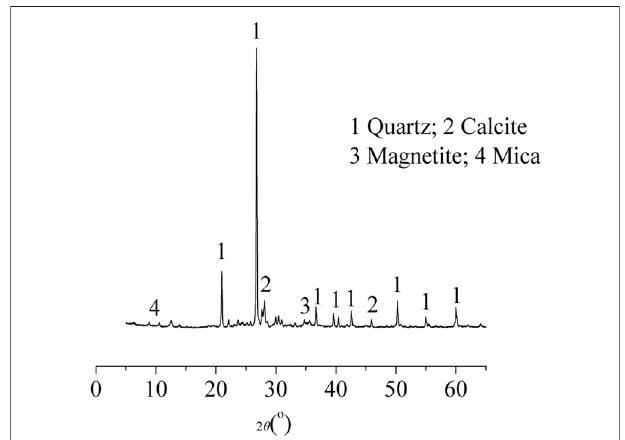
FIGURE 1 | X-ray diffraction pattern analysis of iron tailings